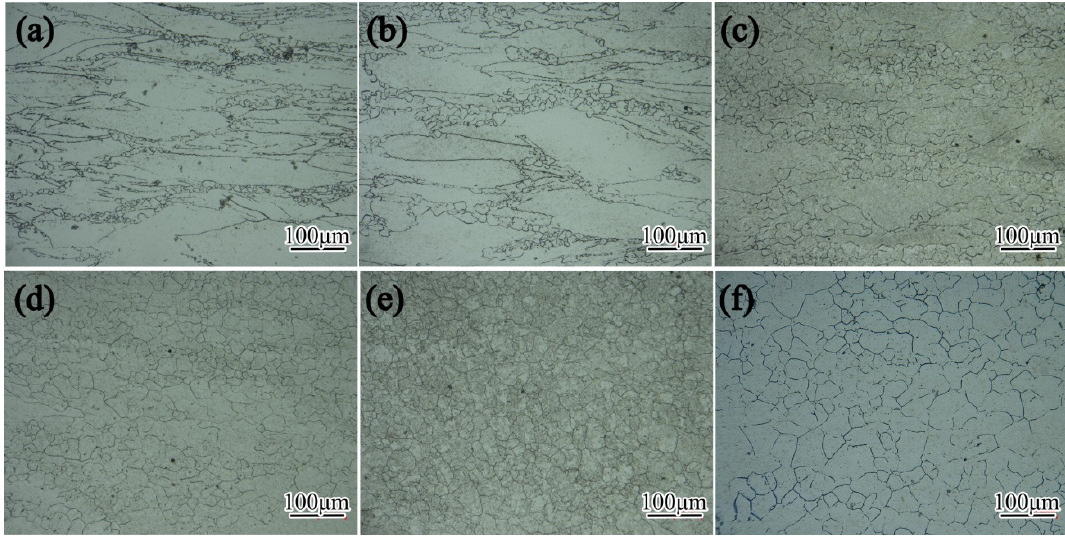
Figure 4. Microstructures of 300M steel compressed at 10 s − 1 and at ( a ) 900 °C, ( b ) 950 °C, ( c ) 1000 °C, ( d ) 1050 °C, (e) 1100 °C, and ( f ) 1150 °C.